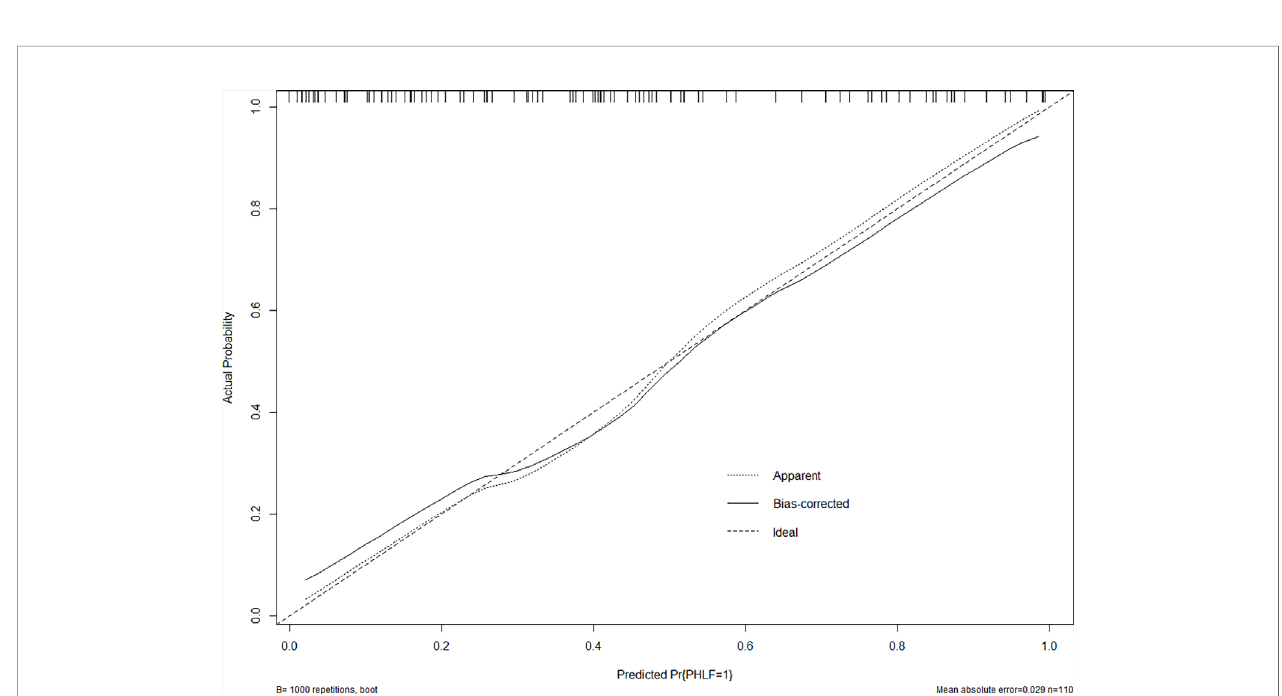
FIGURE 5 | The calibration curve of the nomogram in the validation cohort. The x-axis indicates the nomogram predicted probability of PHLF, and the y-axis represents the actual PHLF rate. The dotted line represents a perfect prediction, and the solid line represents the predictive performance of this nomogram. The closer the solid line fi t is to the dotted line, the better the prediction of the nomogram will